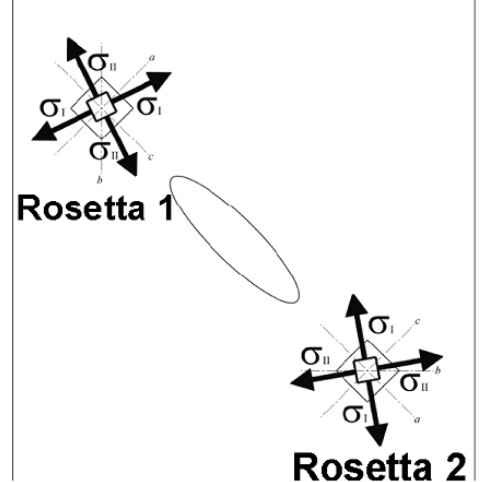
Figura 21: Andamento delle direzioni principali rilevate dalle due